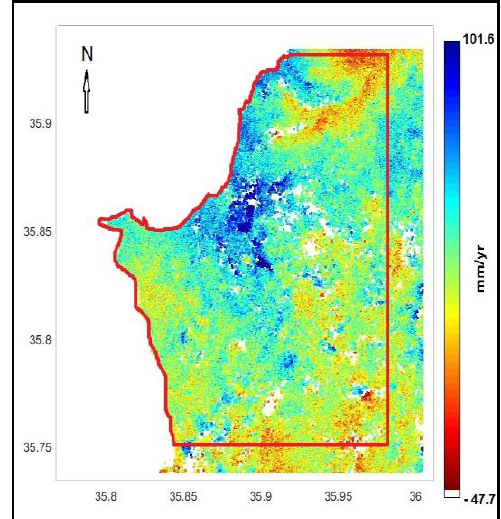
Figure 14. The distribution of the PSs produced by PSI technique and the velocities values during the study period from 16 October 2018 until 21 March 2019. The resulting data was exported to ArcGIS in order to be processed and interpolated using inverse distance weighted (IDW) interpolation method. As the result, a raster map representing the mean velocity map of the ground-surface deformation during the study period from 16 October 2018 until 21 March 2019 was produced as it is shown in figure (15). This map shows values between – 47.70 mm/year and + 101.64 mm/year and also show more clearly the specific locations of extreme ground-surface deformation values which refer to the high landslide intensity areas.